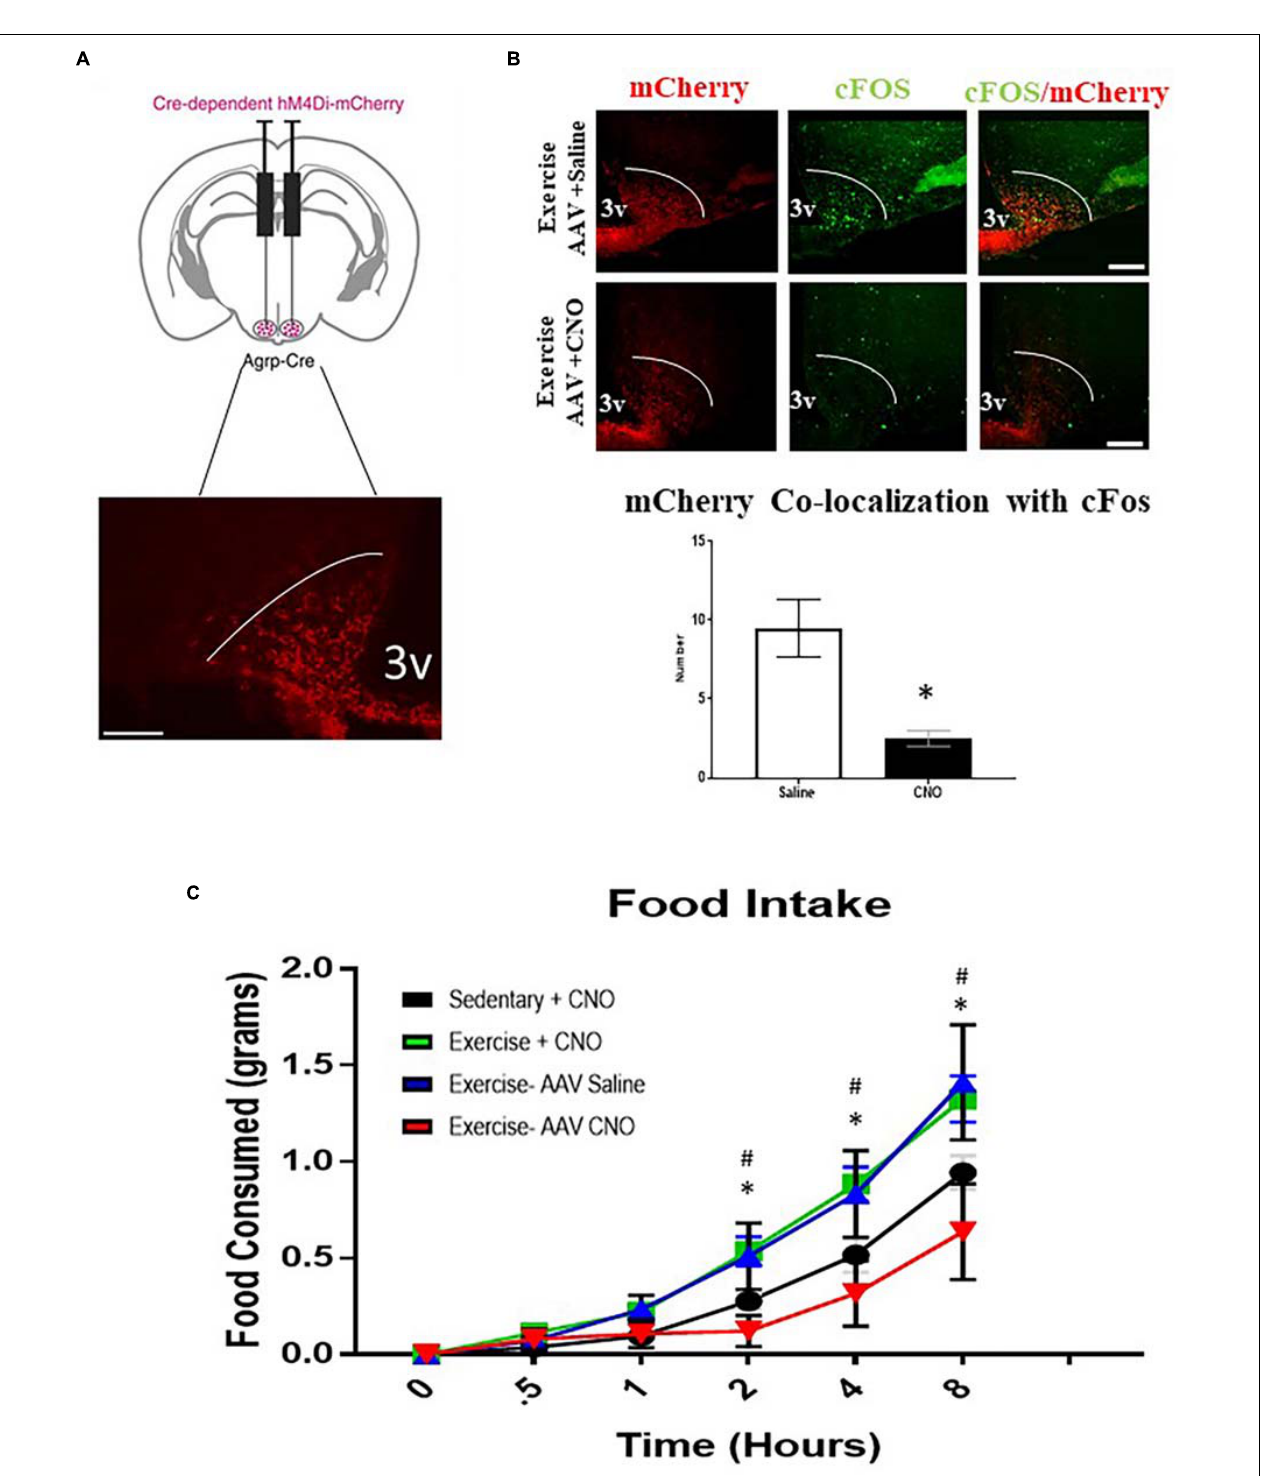
FIGURE 5 | AgRP neuron inhibition abolishes acute exercise induced food intake. (A) Top, targeting scheme for hM4Di-mCherry. Bottom, localization of hM4Di-mCherry with the anatomical location of NPY/AgRP neurons in the ARC. (B) Immunofluorescence and quantification of mCherry positive and cfos-expressing cells in the ARC from AAV CNO and AAV Saline groups immediately after a bout of acute exercise. (C) Cumulative food intake over an 8-hour period immediately after the exercise or sedentary conditions. # indicates significance between Exercise CNO and Sedentary CNO groups ( p < 0.05); * indicates a significant difference between Exercise AAV Saline and Exercise AAV CNO groups ( p < 0.05) ( N = 6 male mice per group). (I.P. CNO and saline injections of 0.3 mg/kg of body weight were applied 30 min prior to exercise). Bar graphs show Mean + SEM. 3V: third ventricle, scale bars represent 50 µ m.